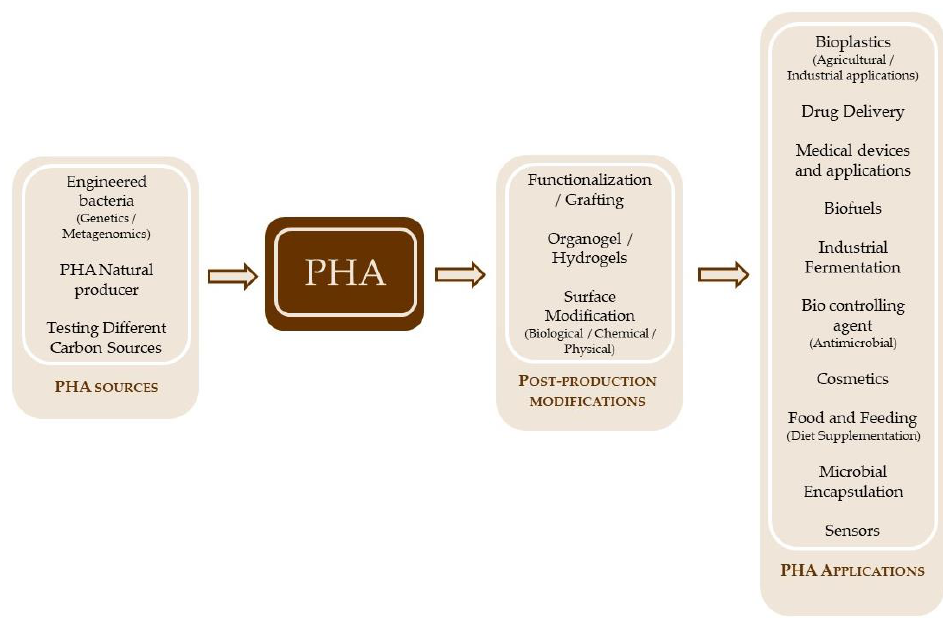
Figure 2. Generalities of PHA